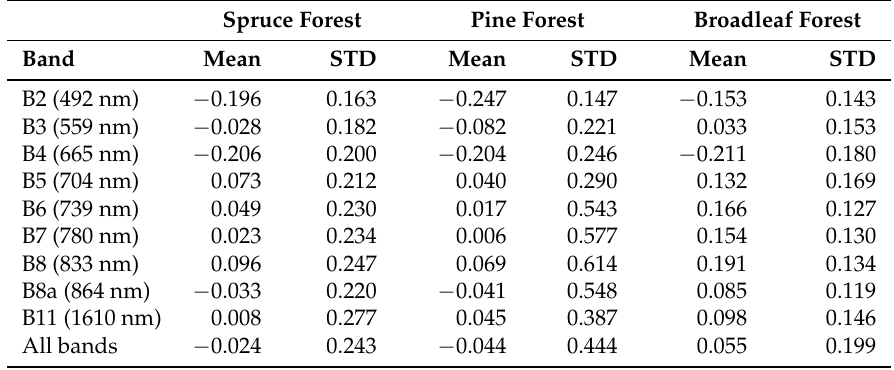
Figure 13. Mean reflectance factors in Sentinel-2 MSI spectral bands and the simulation with the statistical forest reflectance model (SFRM). Table 3. Mean relative errors of simulated reflectance, and their standard deviations (STDs). Spruce Forest Pine Forest Broadleaf